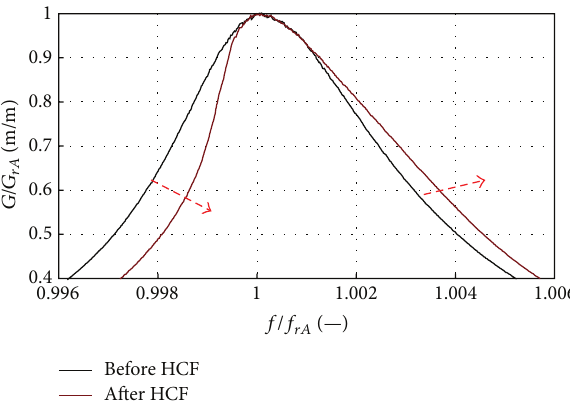
Figure 30: Changes in modal parameters during material weaken- ing phase ( 𝛿𝑓 𝑟𝐴 = −0.5 Hz) [3, 23].